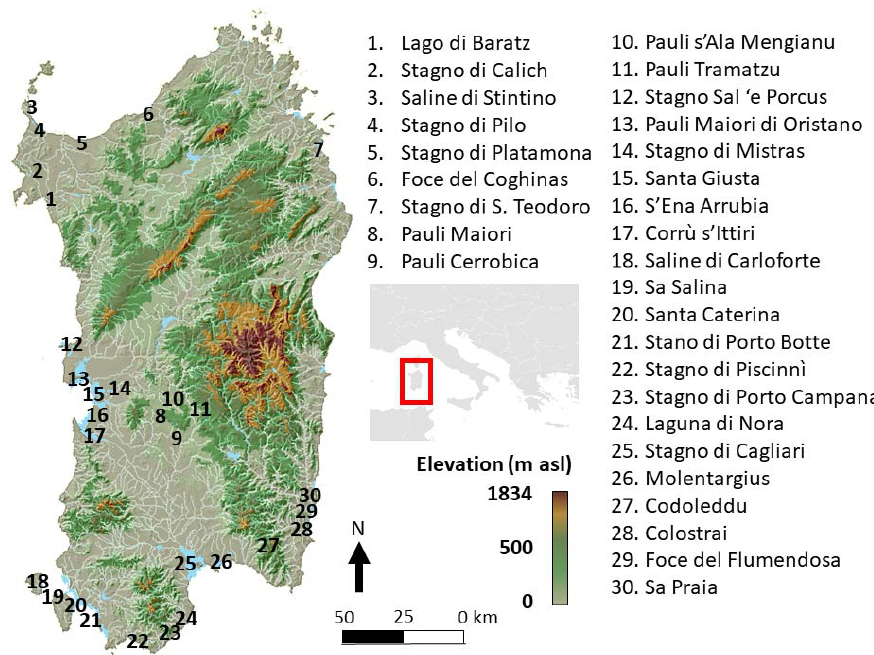
Figure 1. Wetland areas of Sardinia (in blue) and location and names of the 30 study sites. The presence/absence of 323 bird and 844 vascular plant species was recorded for each wetland. Data of both plants and birds were retrieved from all available consulted literature and reports, such as [34]; data repositories, such as wikiplantbase [35] or INaturalist [36], and all available grey literature. These were completely revised by personal data of the authors and, at least, one recent monitoring